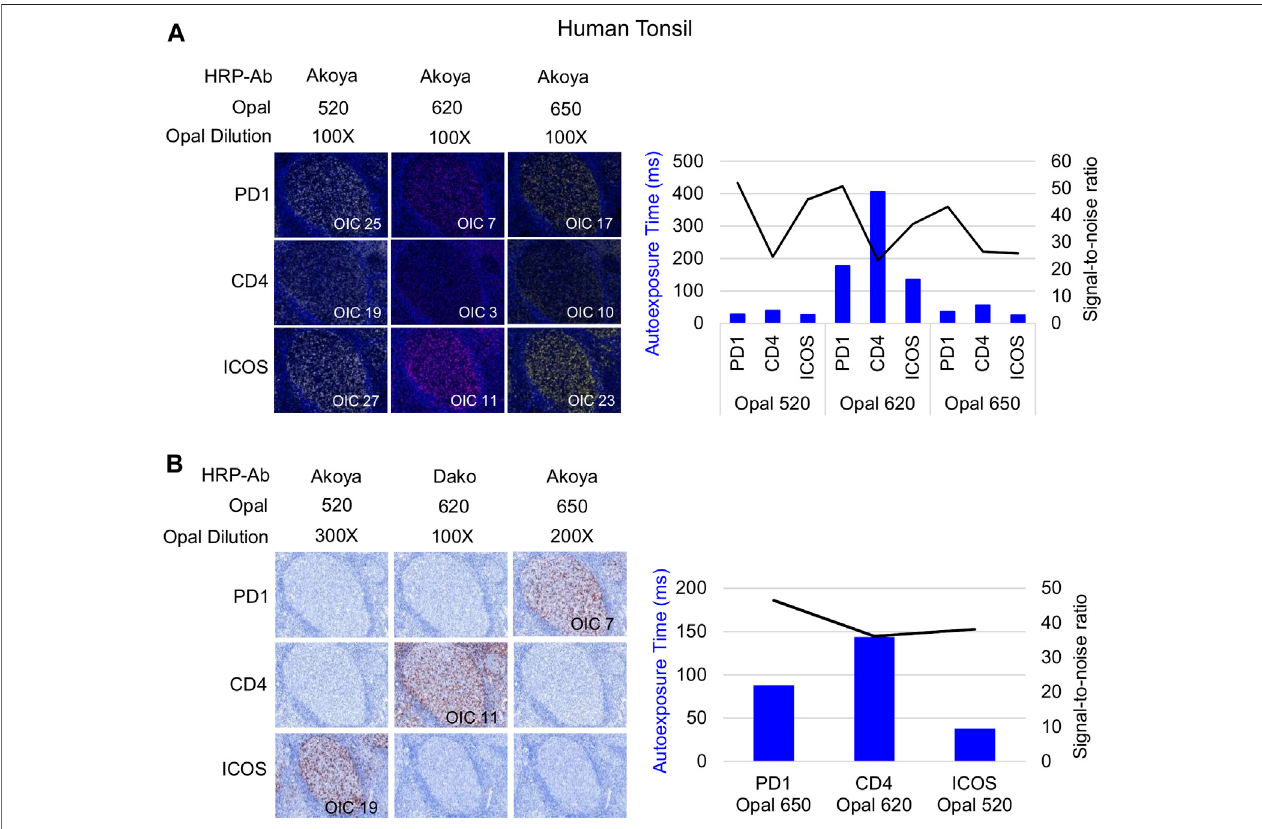
FIGURE3| Antibody-Opalpairingandsignalbalanceofthreemarkersco-localizedonthecellsurface. (A) CompositeimagesofconsecutivemonoplexFFPEtonsil sectionsstainedwithPD-1,CD4,orICOSwithOpal520,620,or650.Thegraphshowstheautoexposuretimes(bluebars)andthesignal-to-noiseratio(blackcurve)for each pairing. The signal-to-noise ratio was calculated via dividing the Opal intensity count (OIC) by the Opal background obtained in InForm. (B) Simulated DAB IHC images of optimized monoplex staining in (A) . The graphic shows the autoexposure times (blue bars) and the signal-to-noise ratio (black curve) of optimized monoplex staining determined by InForm. The slides were scanned at × 20 magni fi cation with the Vectra Polaris and the composite images were analyzed with InForm software (v.2.4.8) and PhenoptrReports (Kent S Johnson (2020). phenoptr: inForm Helper Functions. R package v.0.2.6. https://akoyabio.github.io/phenoptr/).